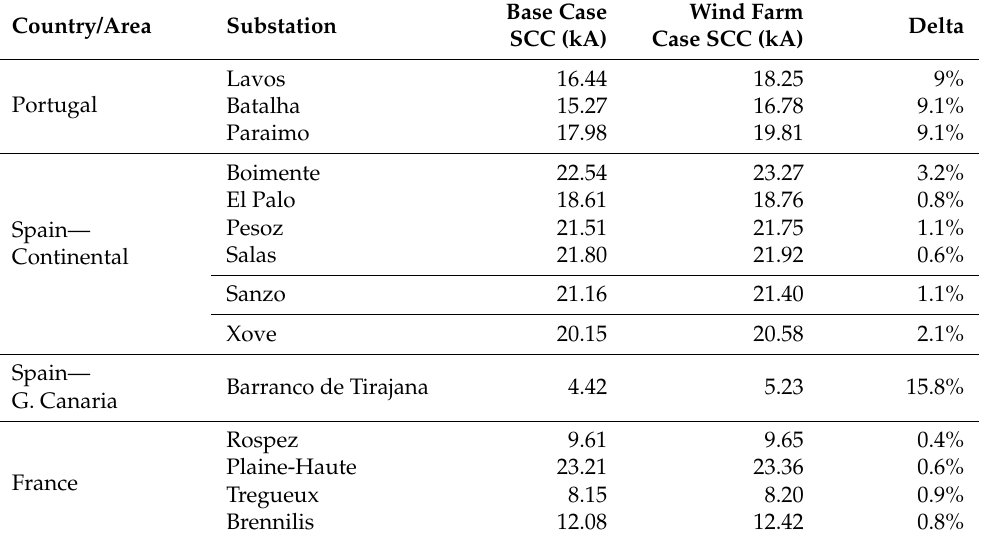
Table 6. Short circuit current